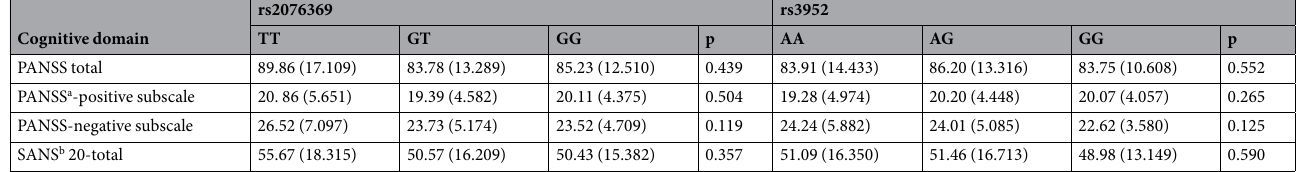
Table 2. Association between genotypes of PICK1 and clinical symptoms in schizophrenic patients. All data were presented by mean (standard deviation). According to normality of data, Analysis of Variance (ANOVA) was used for SANS 20-total and Kruskal-Wallis test for other items. a PANSS = Positive and Negative Syndrome Scale. b SANS = Scale for the Assessment of Negative Symptoms.